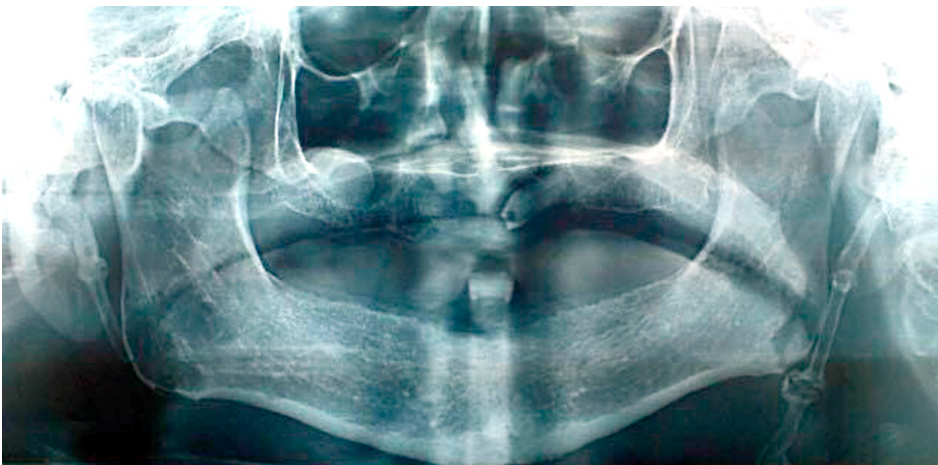
Figure 3. Panoramic x-ray acquisition showing bilaterally pathological nodular elongation of the left and right styloid processes extending beyond the lower border of the mandible; an unerupted impacted maxillary left canine and, on the right side, the sinus mucocele can also be seen.